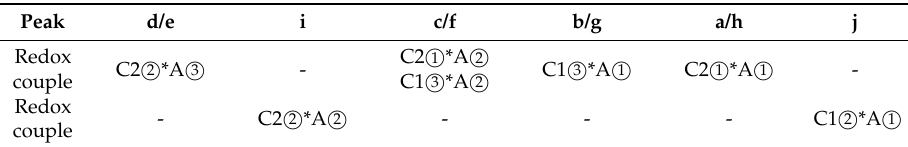
Figure 3. ( a ) Charge/discharge profiles at 0.05 C rate at various hundreds of cycles; ( b , c ) Potential position of the redox reactions of the individual LCO, NMC532 and Gr electrodes vs. Li + /Li, respectively; ( d ) Corresponding dQ/dV plots at 0.05 C rate, (inset) the magnification of the dashed rectangle part; ( e ) Zoomed in dQ/dV plots; ( f ) Open-circuit voltage (OCV)-state of charge (SOC) curve and OCV-ch and OCV-dis at various cycles of the LCO + NMC532/Gr full cells. Table 1. Analysis of peaks in dQ/dV plots based on electrode chemistries of LCO + NMC532 cathode and Gr anode.